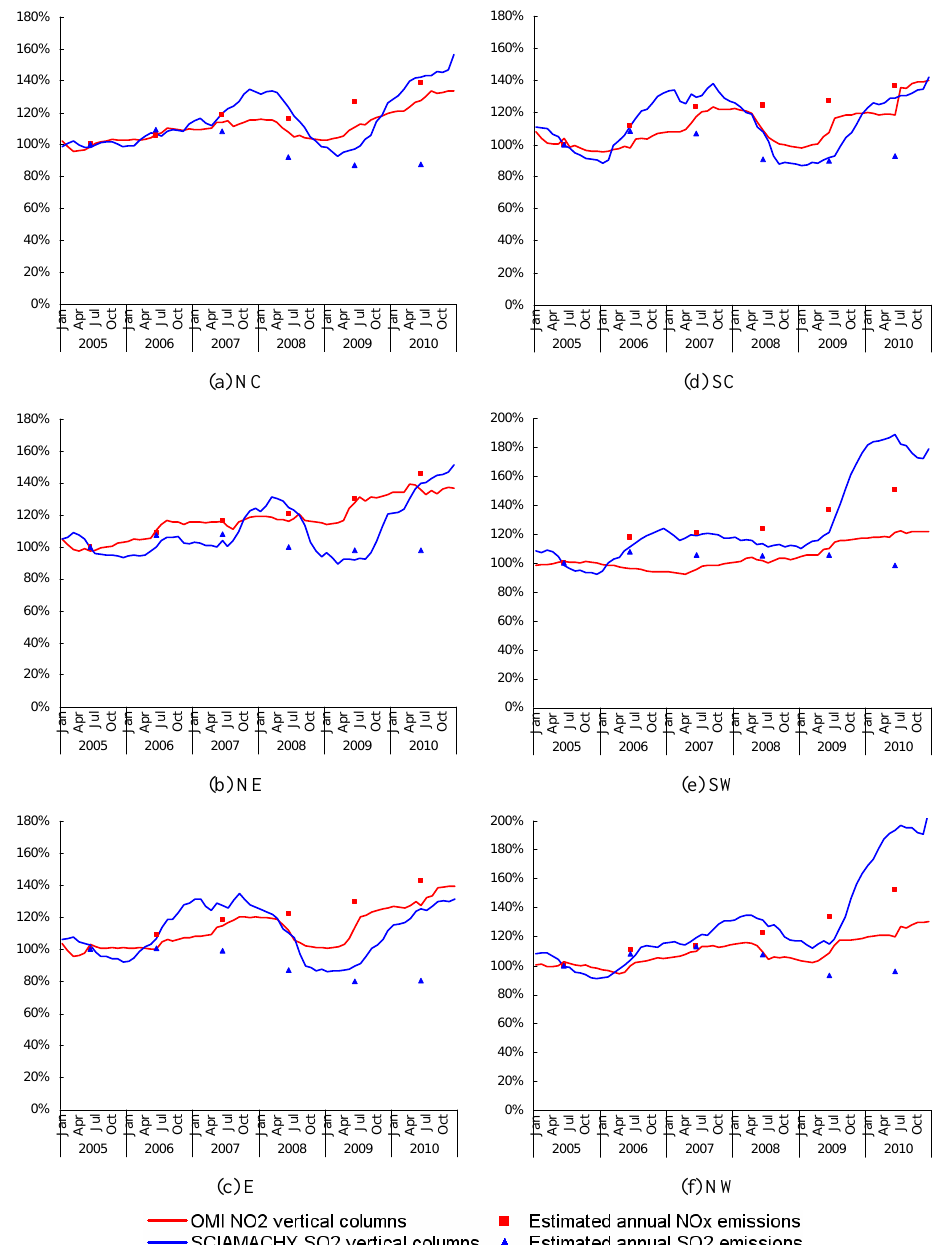
Fig. 5. The comparisons of inter-annual trends between satellite observation and bottom-up emissions from 2005 to 2010. All the data are normalized to 2005